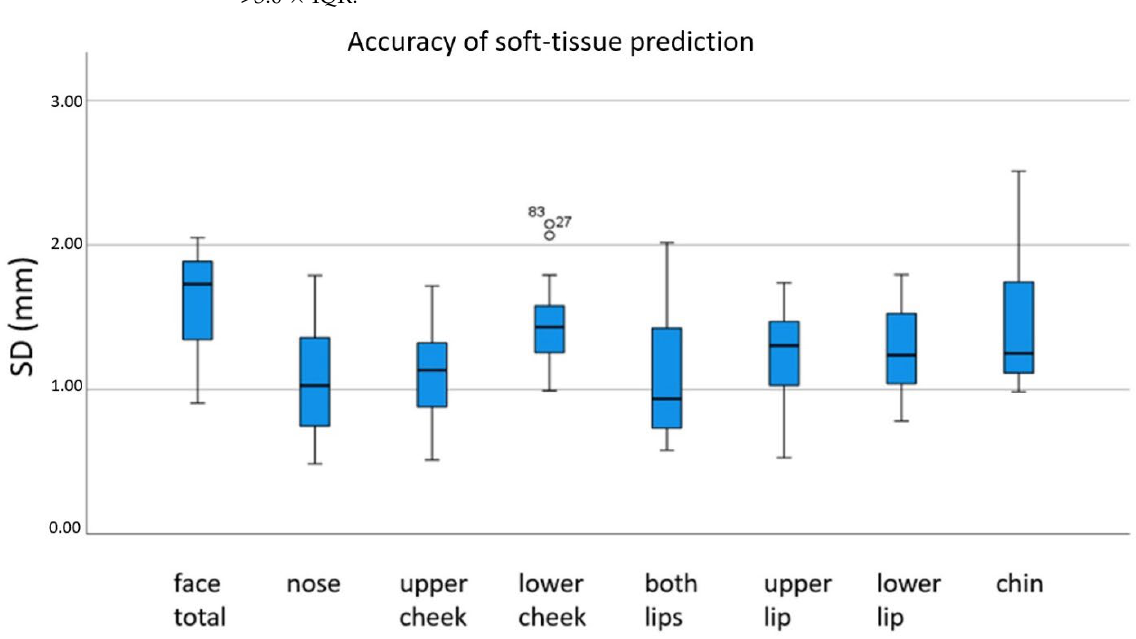
Figure 6. Standard deviation between postoperative 3D scan and preoperative soft-tissue simulation. °: moderate outlier: 1.5 – 3.0 x IQR (interquartile range).